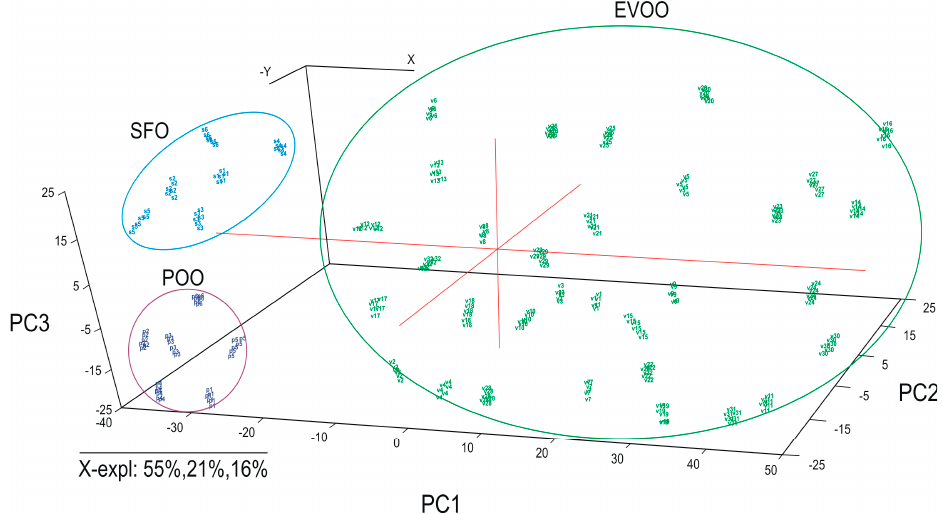
Figure 4. PCA scores plot corresponding to the CV data corresponding to different categories of oils: EVOO, POO and SFO samples.